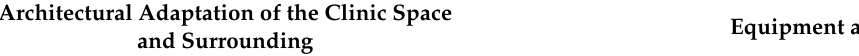
Table 4. Two aspects of PHC clinic accessibility indicated by PVIs.